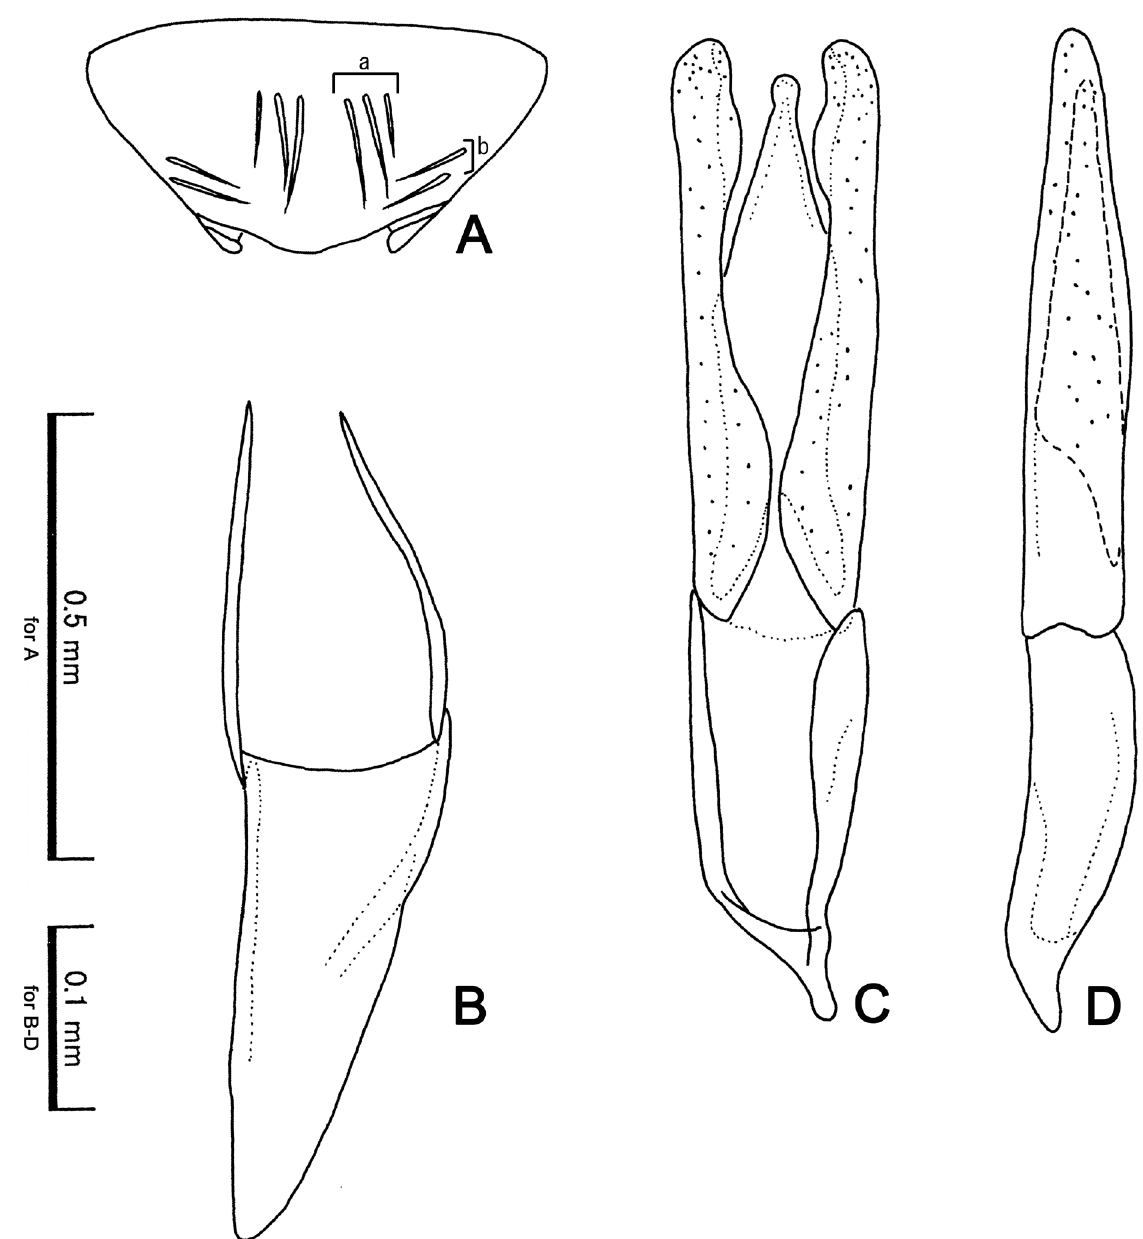
Fig. 10. Pseudeucinetus papuanus sp. nov., male genitalia, holotype, BPBM. A . Sternite VII. B . Sternite IX. C . Aedeagus, ventral view. D . Aedeagus, right